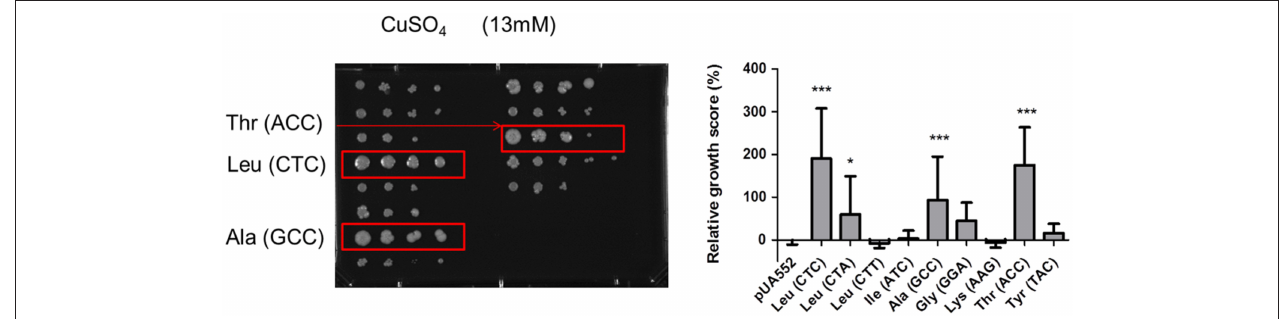
FIGURE 3 | Growth on YEPD supplemented with 13mM of CuSO4. Strains misincorporating serine in leucine CTC, alanine GCC and threonine ACC showed an advantageous growth phenotype. Data represent the mean ± standard deviation of triplicates of three independent clones ( *** p < 0.001; * p < 0.05 one-way Anova